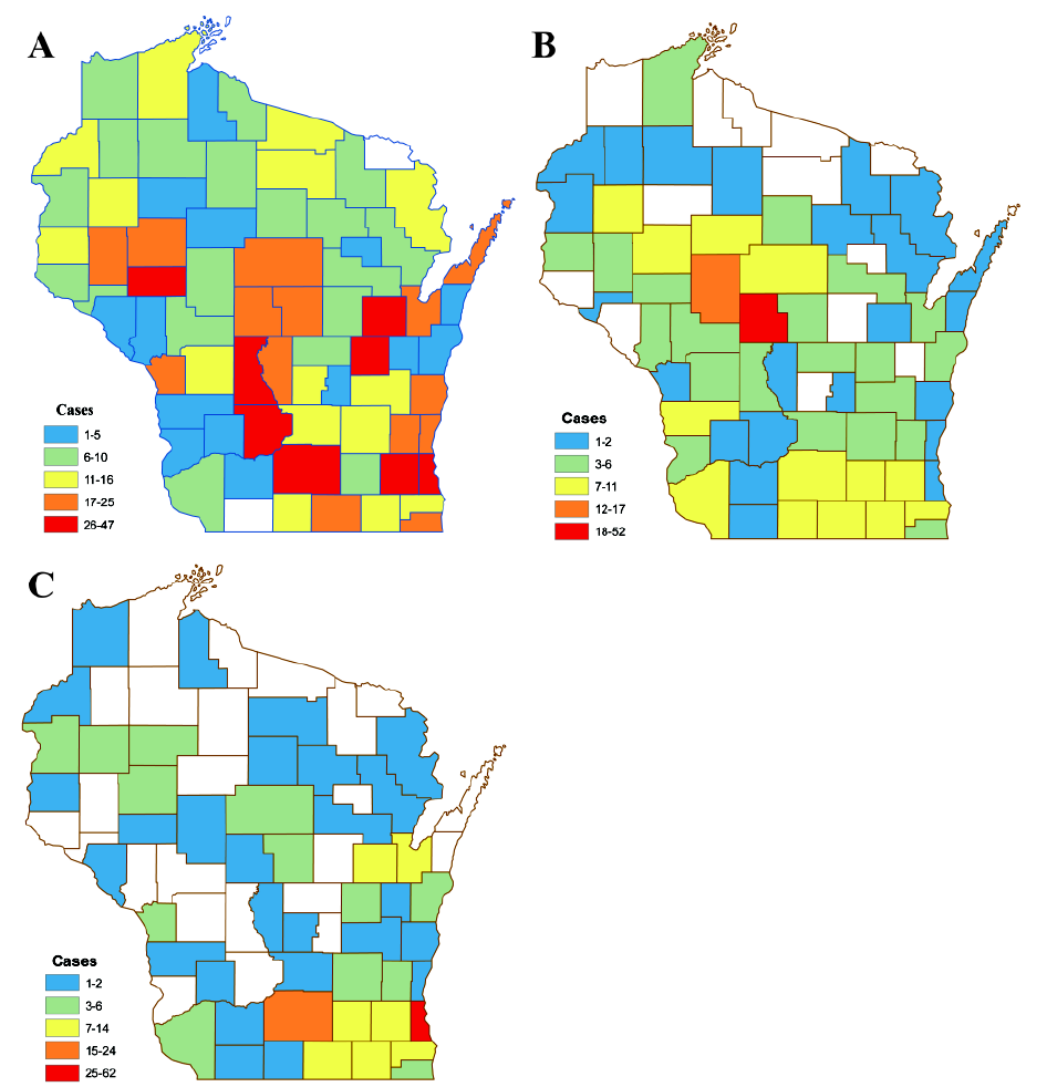
Figure 2. Wisconsin choropleth map of total confirmed positive and probable West Nile virus cases by county for all avian ( A ), equine ( B ), and human ( C ) species, 2001–2016. Values are defined based on quintiles of confirmed and / or probable cases. Counties in white have no positive confirmed WNV cases.